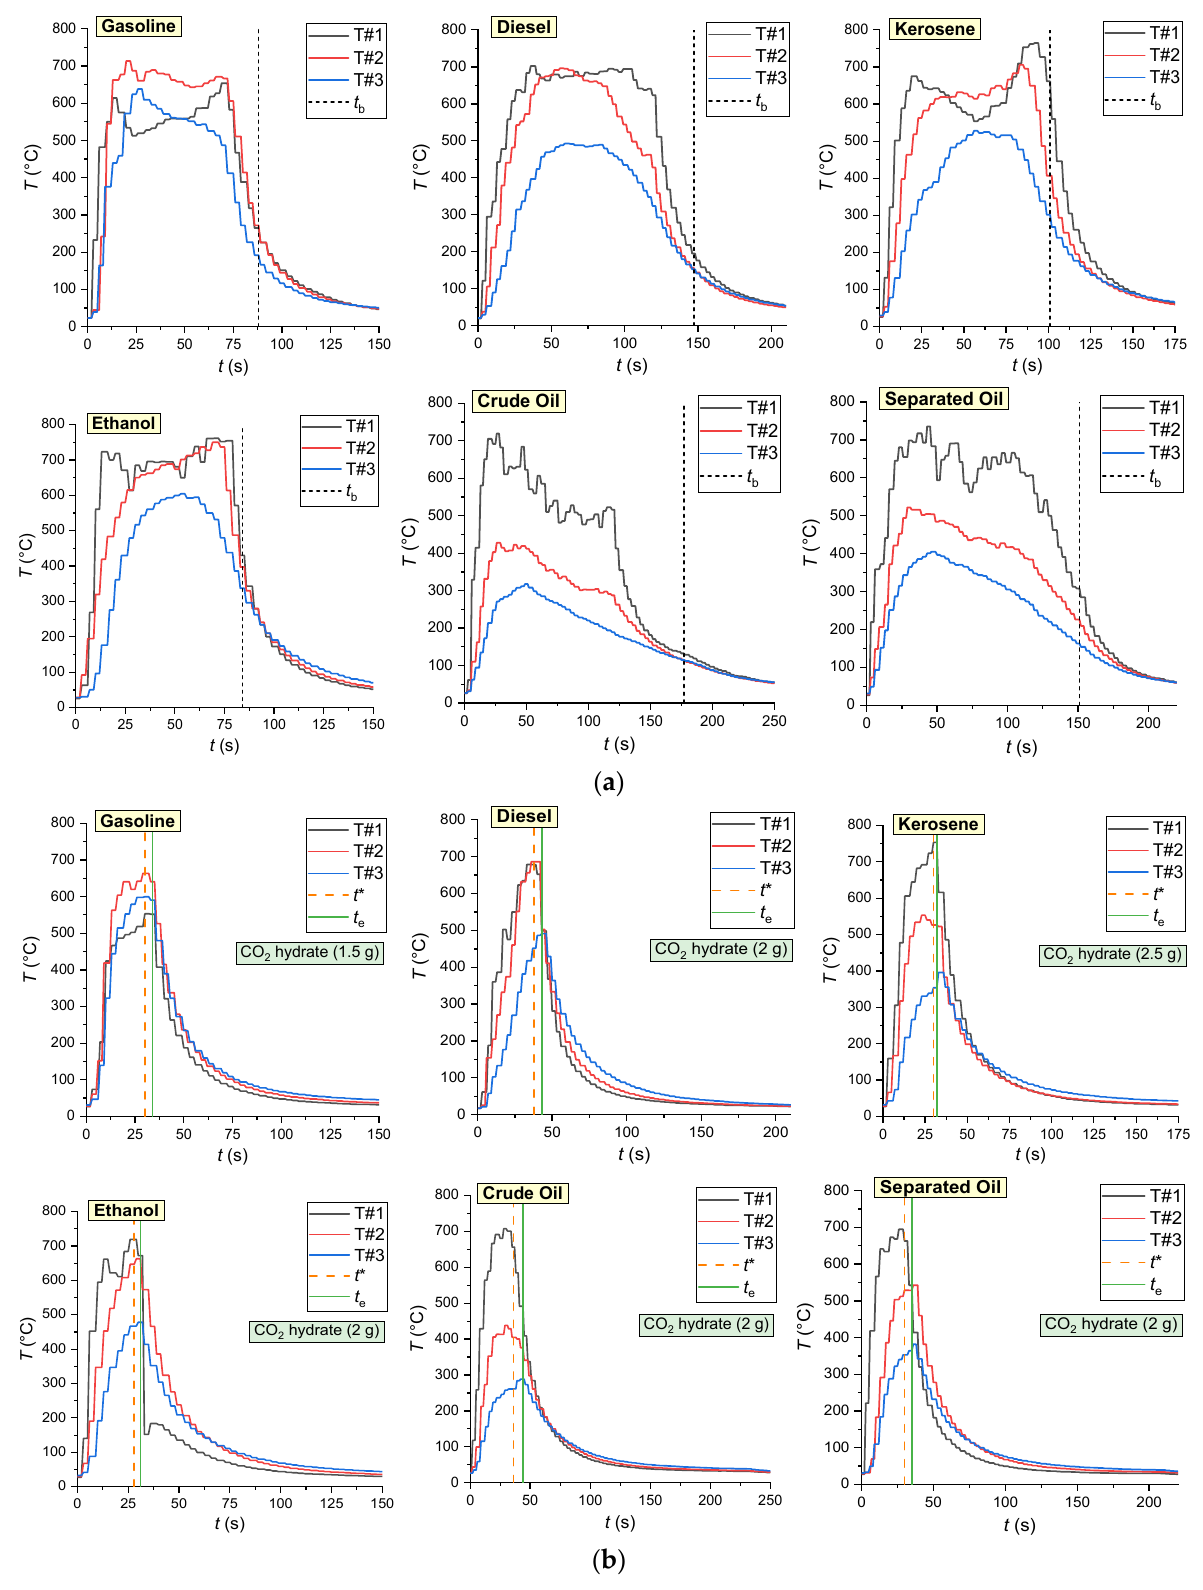
Figure 17. Flame temperature variation dynamics of laboratory-scale fires involving different flam- mable liquids ( V 0 ≈ 3 mL, d f ≈ 50 mm, S f ≈ 20 cm 2 ) without extinguishing ( a ) and when suppressed by CO 2 hydrate powder ( b ).